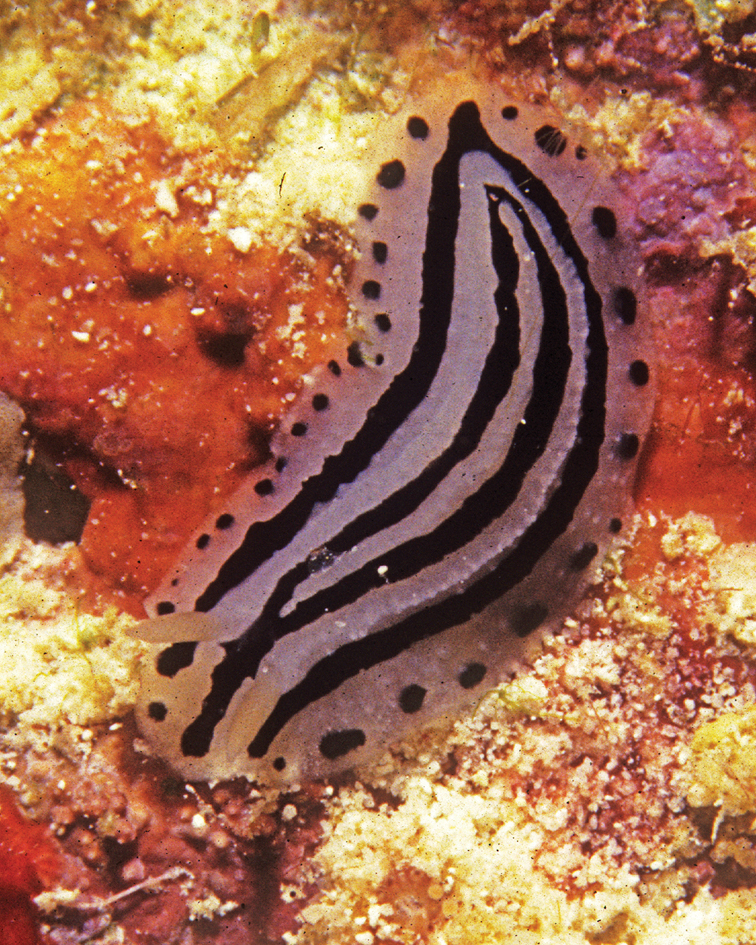
Phyllidiopsis xishaensis, 10 mm, Maldives, photo: RC Anderson.